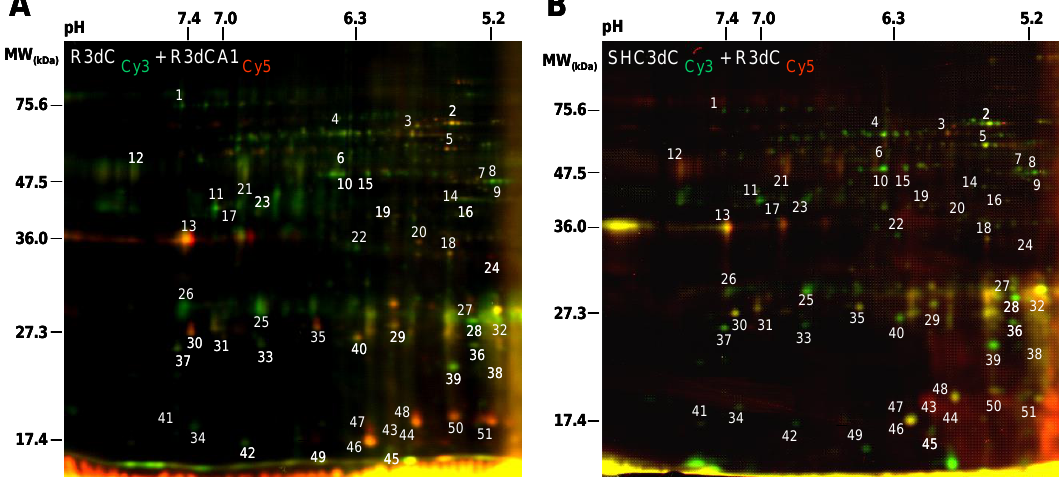
Figure 2. Differential detection of 4E-BP2-interacting proteins in response to ischemia-reperfusion. ( A ) 2-D DIGE scanned images overlay of the 4E-BP2 immunoprecipitate from R3dC sample, labelled with Cy3 (green), combined with the 4E-BP2 immunoprecipitate from R3dCA1, labelled with Cy5 (red), comparing cerebral cortex and CA1 samples from ischemic animals (R3dC/R3dCA1 combination). ( B ) 2-D DIGE scanned images overlay of the 4E-BP2 immunoprecipitate from SHC3dC control sample, labelled with Cy3 (green), combined with the 4E-BP2 immunoprecipitate from R3dC, labelled with Cy5 (red), comparing cerebral cortex samples from control and ischemic animals (SHC3dC/R3dC combination). Yellow color is due to the merge of green and red fluorescence labels. The images are representative of eight different experiments performed in paired combination of four different samples ( n = 4) from each of the experimental groups (SHC3dC, SHC3dCA1, R3dC and R3dCA1), and each one of them from a pool of four independent animals. Gel images are full original images; the horizontal axis represents pH and the vertical axis represents molecular weight (MW, in kDa). Detected proteins (spots) in all samples were quantified and spots that showed a differential intensity were tagged with numbers.